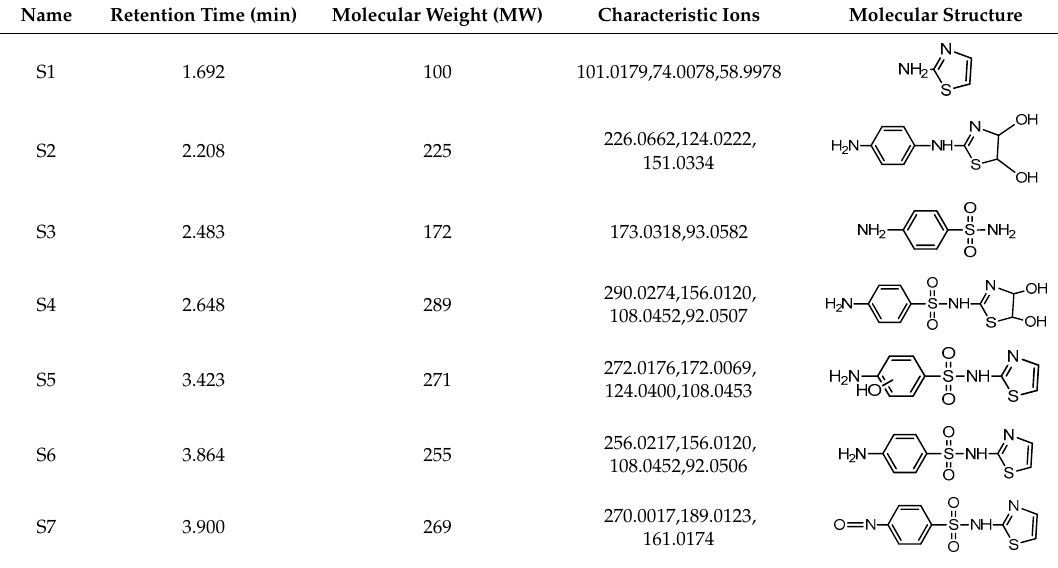
Table 4. The structure of transformation products and their MS fragmentation data in the UV/H 2 O 2 oxidation process of STZ.